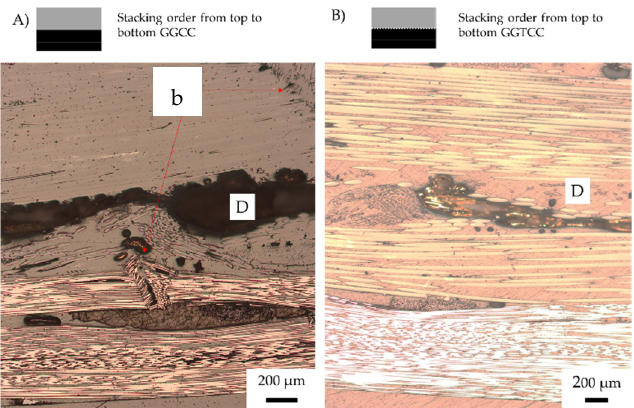
Figure 21. Post-failure micrographs of carbon/glass hybrid fibre failure mechanisms after three-point bending: ( A ) GGCC, ( B ) GGTCC. Annotation: b (fibre buckling) and D (delamination). Red lines indicate fibre failure, fibre direction shown with red arrow.